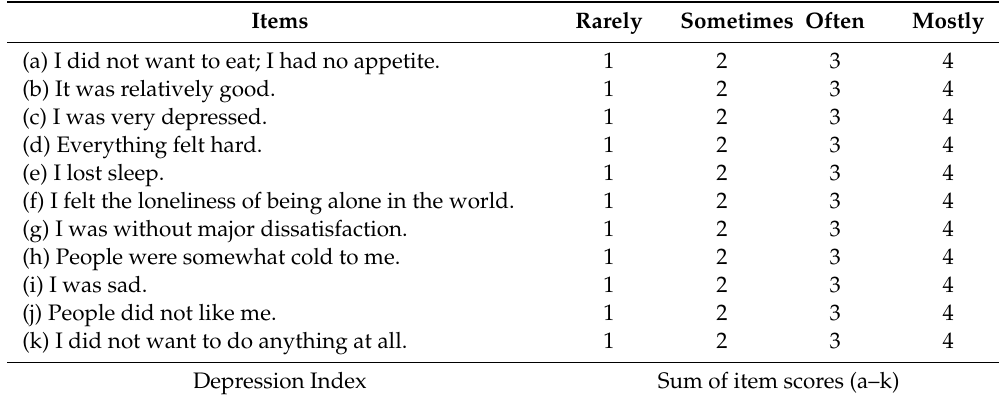
Table 1. Depression index questionnaire.